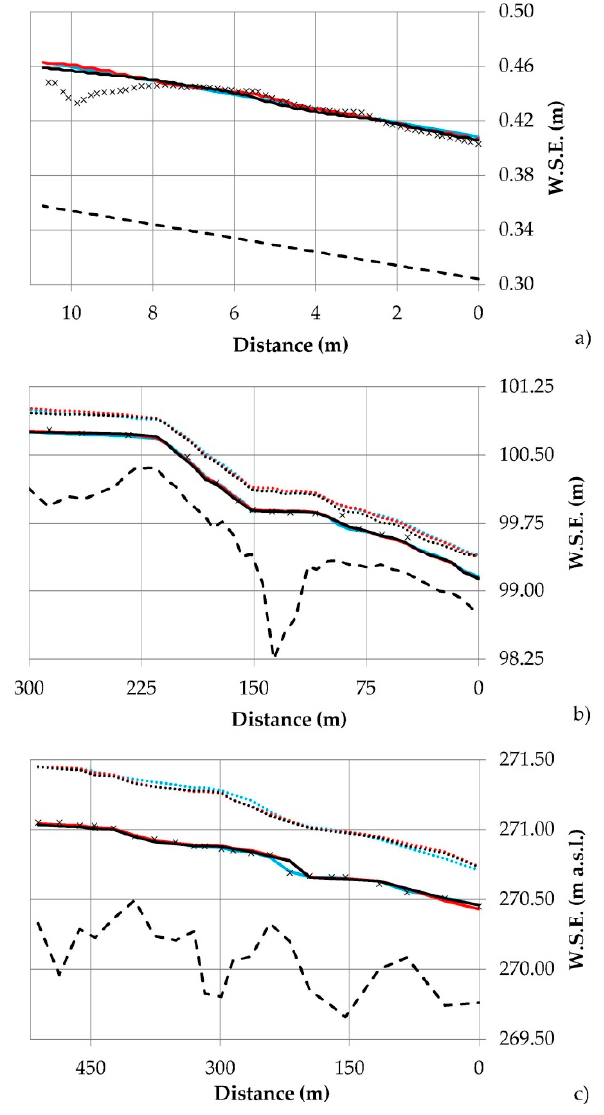
Figure 2. Calibration—Longitudinal profile plots of ( a ) C.1, ( b ) C.2 and ( c ) C.3 including bed elevations (dashed black line) and comparisons of measured (black crosses) and modelled water surface elevations (W.S.E.) at low flow ( Q L ) conditions (results of 1D simulations = blue solid line, 2D simulations = red solid line and 3D simulations = black solid line); Comparison of modelled W.S.E. at an additional discharge scenario (mean flow Q M ) in C.2 and C.3 (results of 1D simulations = blue dotted line, 2D simulations = red dotted line and 3D simulations = black dotted